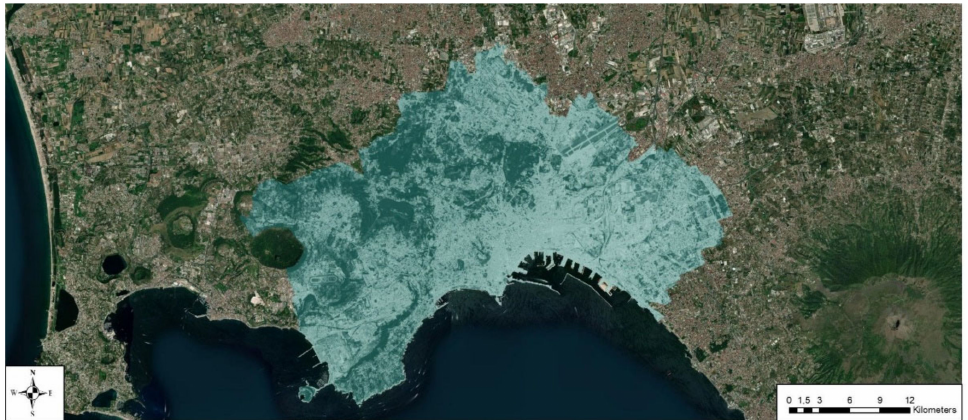
Figure 11. The study area: satellite image of the NDVI index on the municipality of Naples (Italy). The expert sets the initial fuzzy partition on the domain [ − 1, 1], given by four triangu- lar fuzzy sets as in Figure 12.